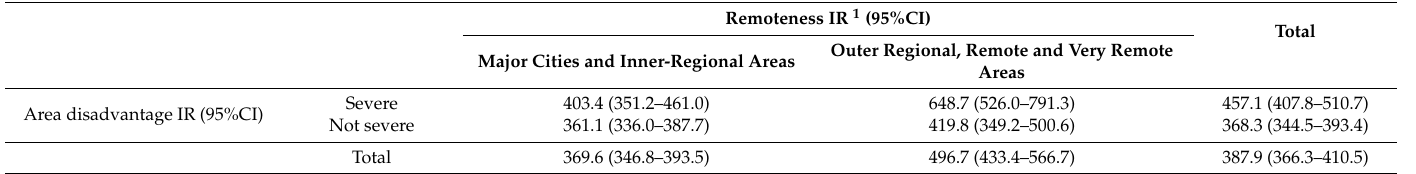
Table 2. Crude incidence rate (IR) of hospitalisation according to remoteness and area